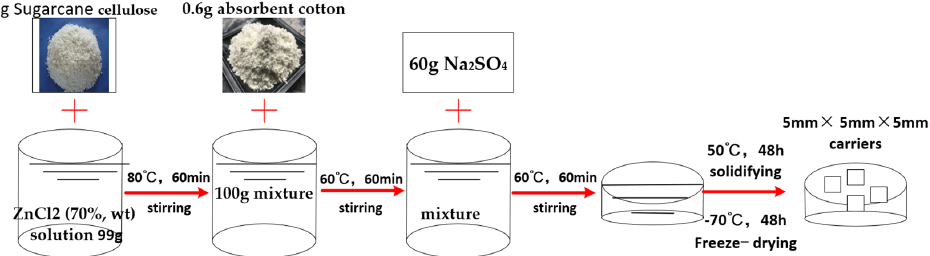
Figure 1. Preparation of carrier.